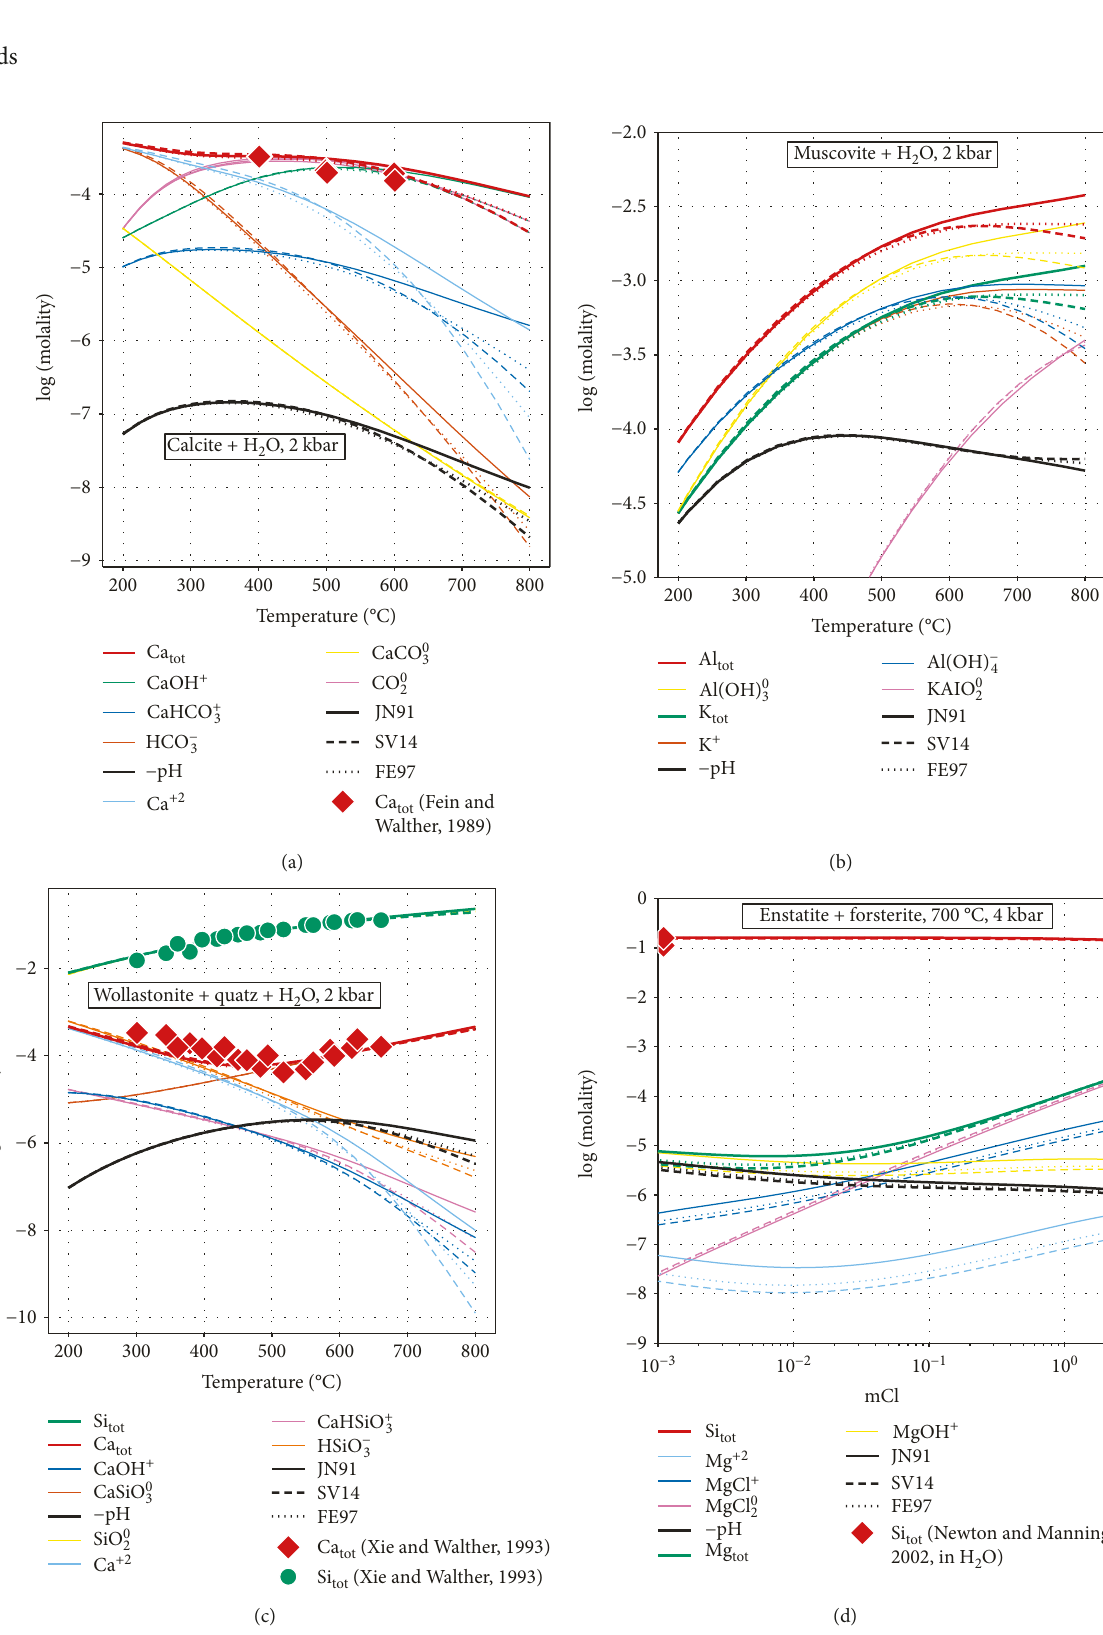
Figure 8: Mineral solubility in water as a function of temperature at 2kbar, calculated using the JN91, SV14, and FE97 models for water dielectric properties and IAPWS95 for water volumetric properties: (a) calcite solubility, (b) muscovite solubility, and (c) wollastonite +quartz solubility; (a, b, c) in pure water at 2 kbar with varying temperature; (d) enstatite +forsterite solubility in NaCl solution of varying molality at 700 ° C and 4 kbar. Total amounts of dissolved elements as well as the species concentrations and negative pH are shown. Symbols represent element concentrations measured in